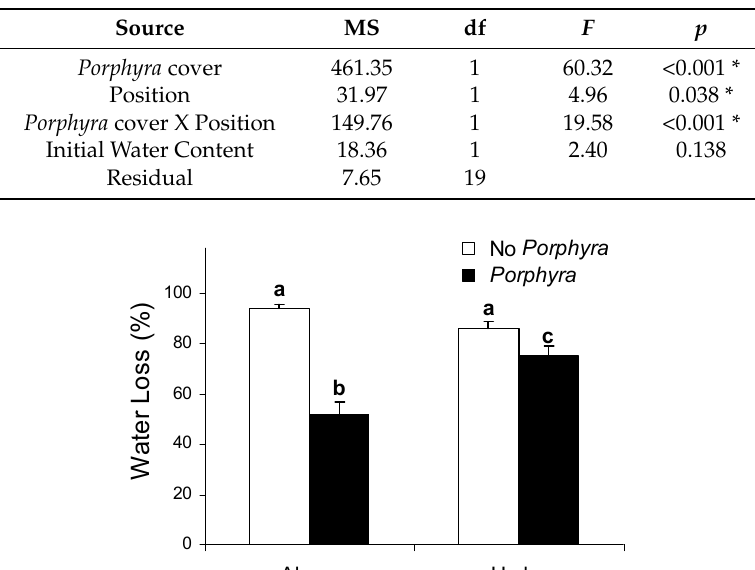
Table 4. Two-way PERMANOVA comparing the composition of interstitial invertebrate assemblages across Treatments ( Porphyra removal vs. Control plots) and experimental Sites/Dates (Punta Cantera/2011, Las Brusquitas/2015, and Copacabana/2017). Asterisks indicate significant effects. Source MS df p Treatment 1.36